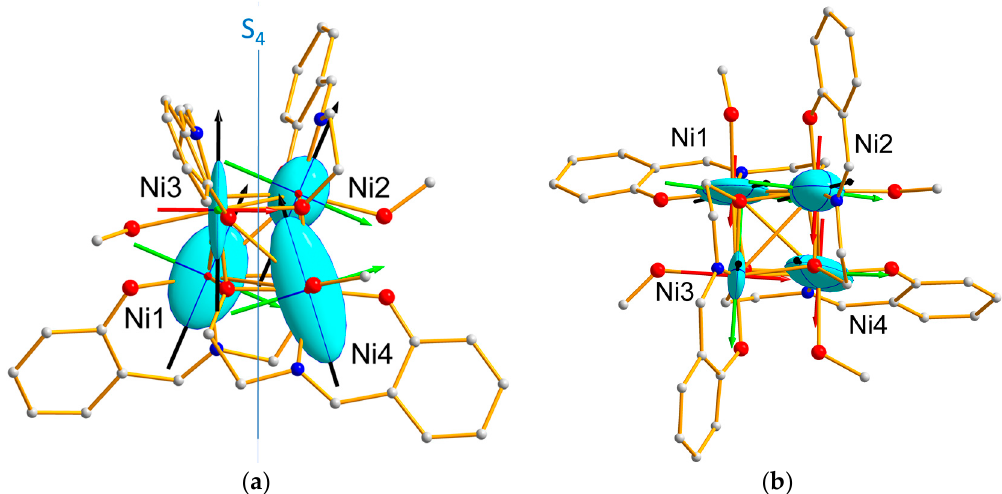
Figure 7. Magnetic ellipsoids associated to the Ni effective single ion susceptibility tensors: ( a ) in projection along the crystallographic c axis; and ( b ) in projection along the pseudo S 4 axis. Easy axes are in black, mean axes in green and hard axes in red. The pseudo-symmetry axis S 4 is represented in blue.